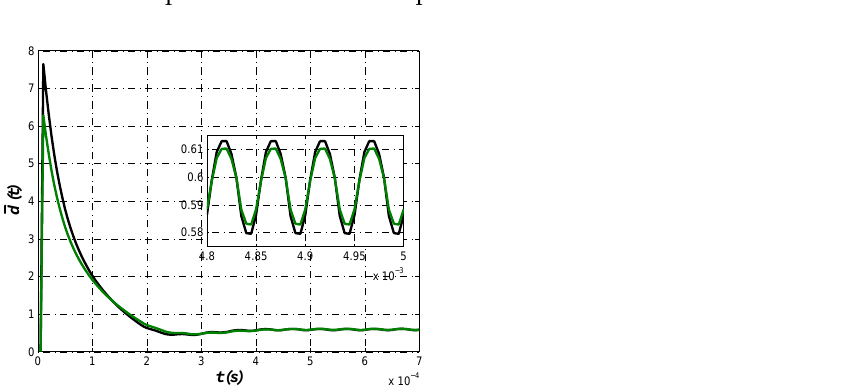
Figure 11. Control laws comparison for both optimization algorithms when minimizing criteria J 1 and J 2